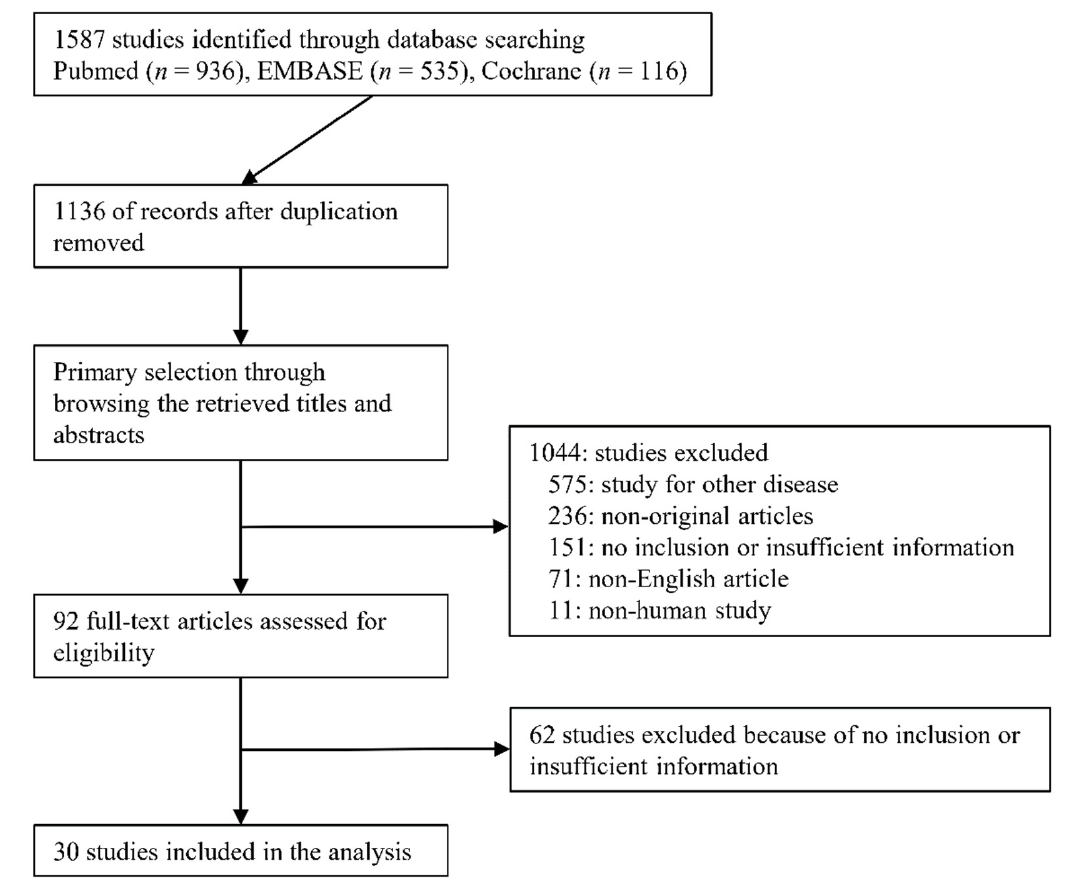
Figure 1. Flow diagram for identification of eligible studies.